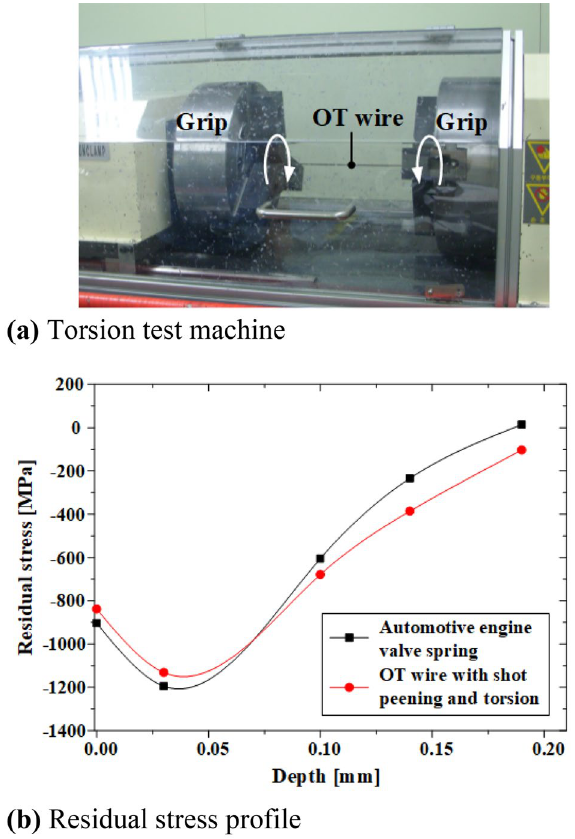
Figure 23. Comparison of residual stresses in automotive engine valve spring and OT wire.